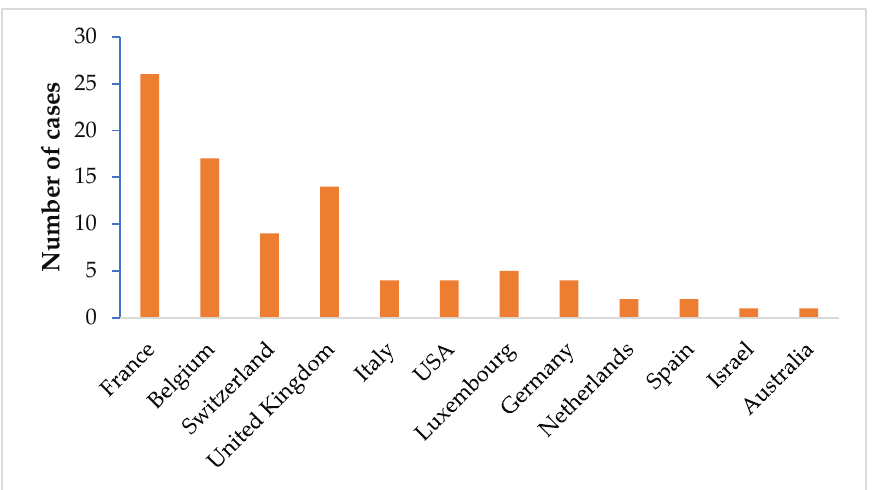
Figure 2. Countries in which confirmed or probable cases of airport malaria have been reported in 2006 [6].